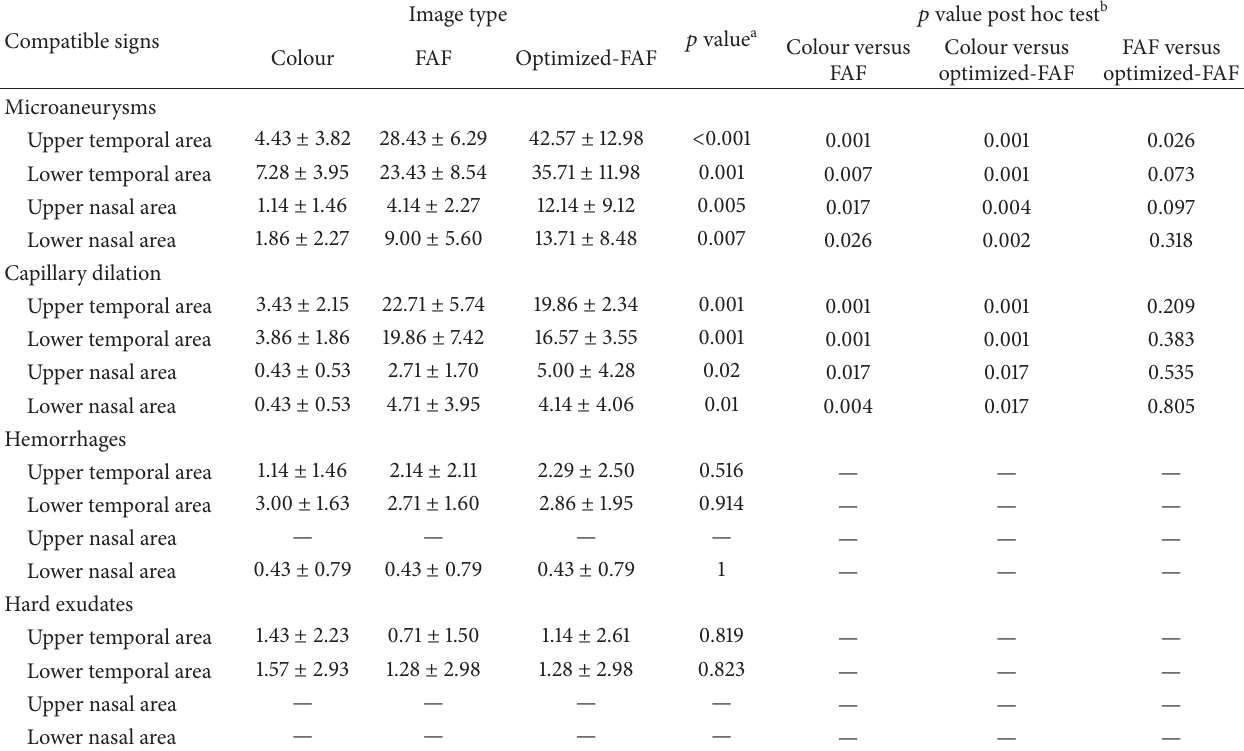
Table 3: Distribution of retinal alterations observed in colour, FAF, and optimized-FAF images in diabetic patients. Compatible signs